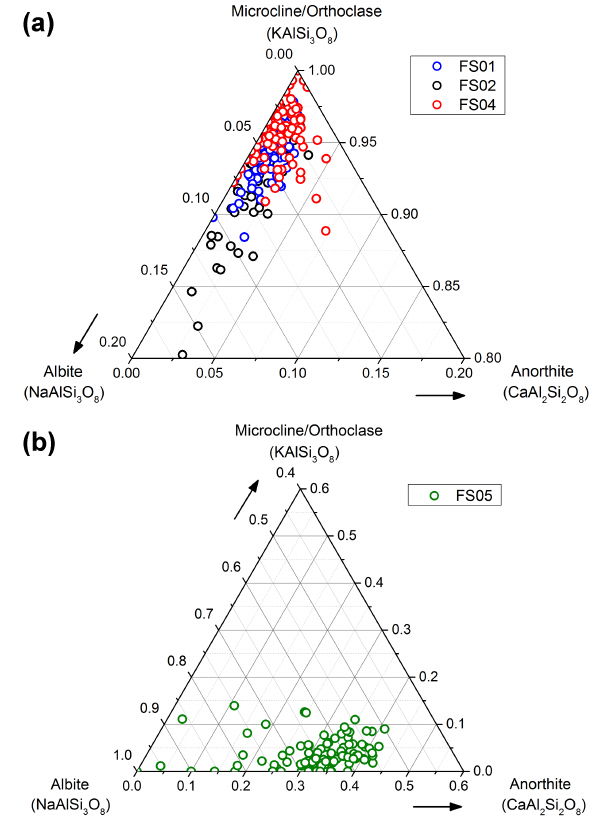
Figure 3. EDX data of individual feldspar particles plotted on the ternary phase diagram based on elemental mass percentages. (a) Ternary phase diagrams of K-feldspar particles (FS01, FS02, and FS04) and (b) Na/Ca-feldspar particles (FS05). Note the differ- ent scales of the ternary